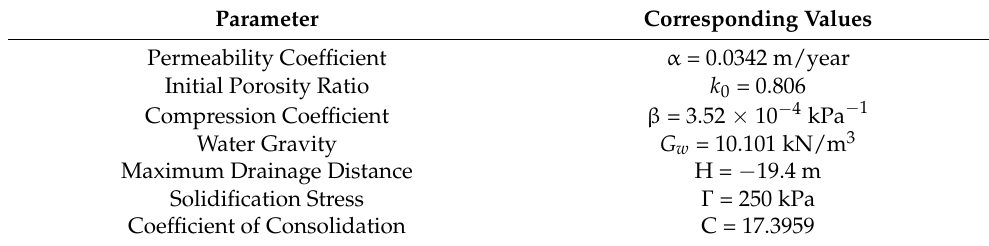
Table 2. Experiment data in the airport.